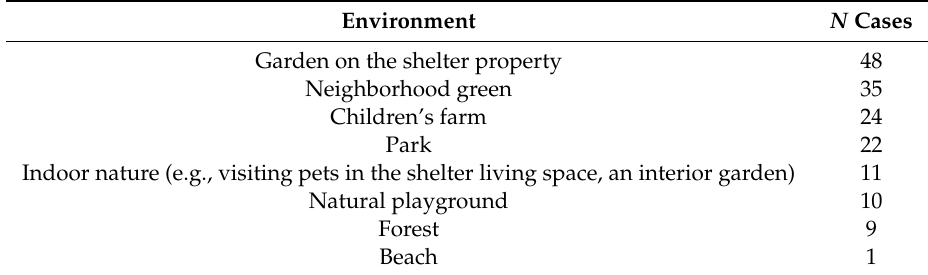
Table A1. Natural Environments Used for Experiencing Nature.